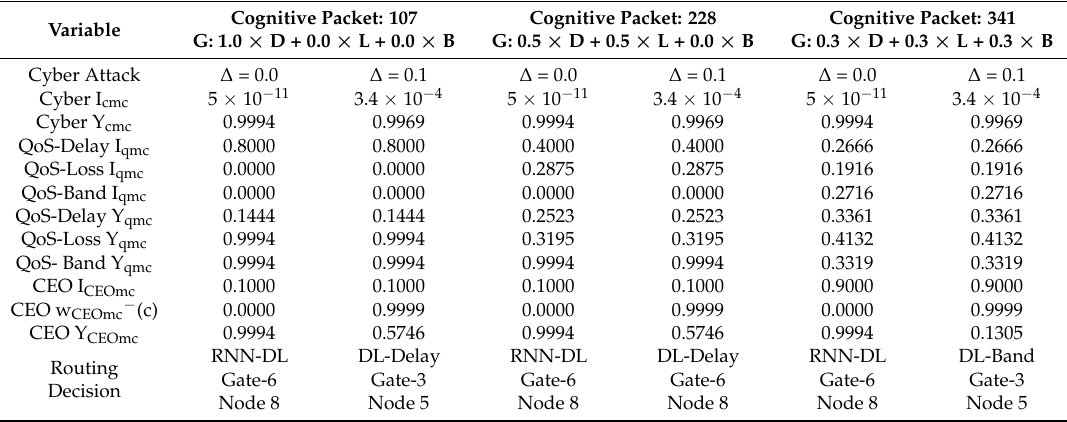
Table 14. DL Management Cluster Validation (4 × 4 Nodes).